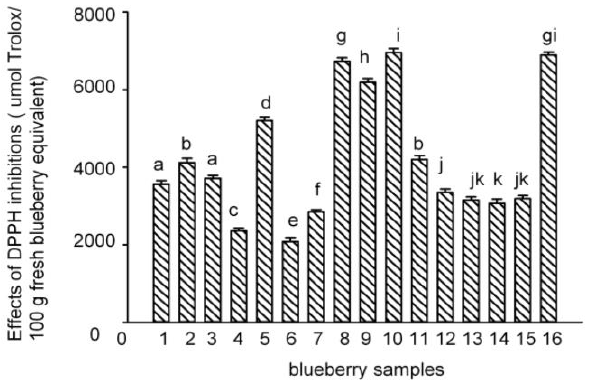
Figure 3. Effects of 1,1-diphenyl-2-picrylhydrazyl (DPPH) inhibition in the 16 blueberry polyphenol fractions. (The results have been expressed in terms of µmol Trolox/100 g fresh blueberry equivalent, means ± SD, n = 3; columns with the different letters are significantly different, p < 0.05, n = 3).